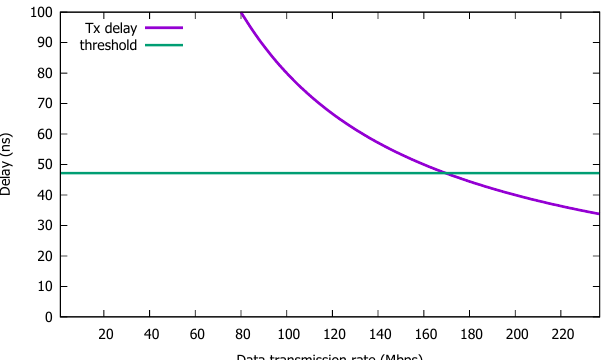
Figure 7. One byte transmission time vs data rate. This delay represents the time that a 8 bit guard time can effectively hold for different data rates.